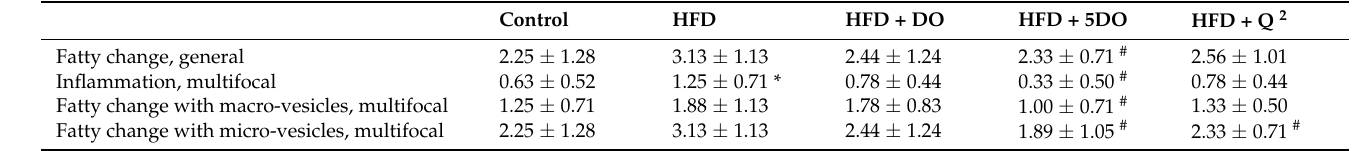
Figure 2. Effect of dried onion powder and quercetin on HE staining images ( A ) as well as mRNA ( B ) and protein ( C ) levels of ACC- α in liver in rats exposed to HFD. The animals were treated with a high fat diet (HFD) along or supplemented with dried onion powder (1% or 5%; DO and 5DO, respectively) or quercetin (Q) for 12 weeks. The control group was given the control diet. Values (mean ± SD) not sharing a common letter are significantly different ( p < 0.05). Table 5. Dried onion powder and quercetin reduced hepatic steatosis in Sprague Dawley rats exposed to HFD 1 .